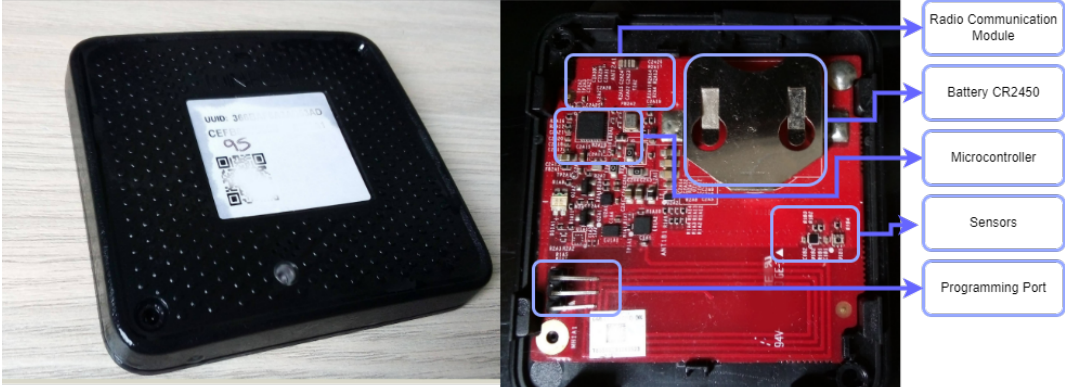
Figure 1. IoT Monitoring CSCG